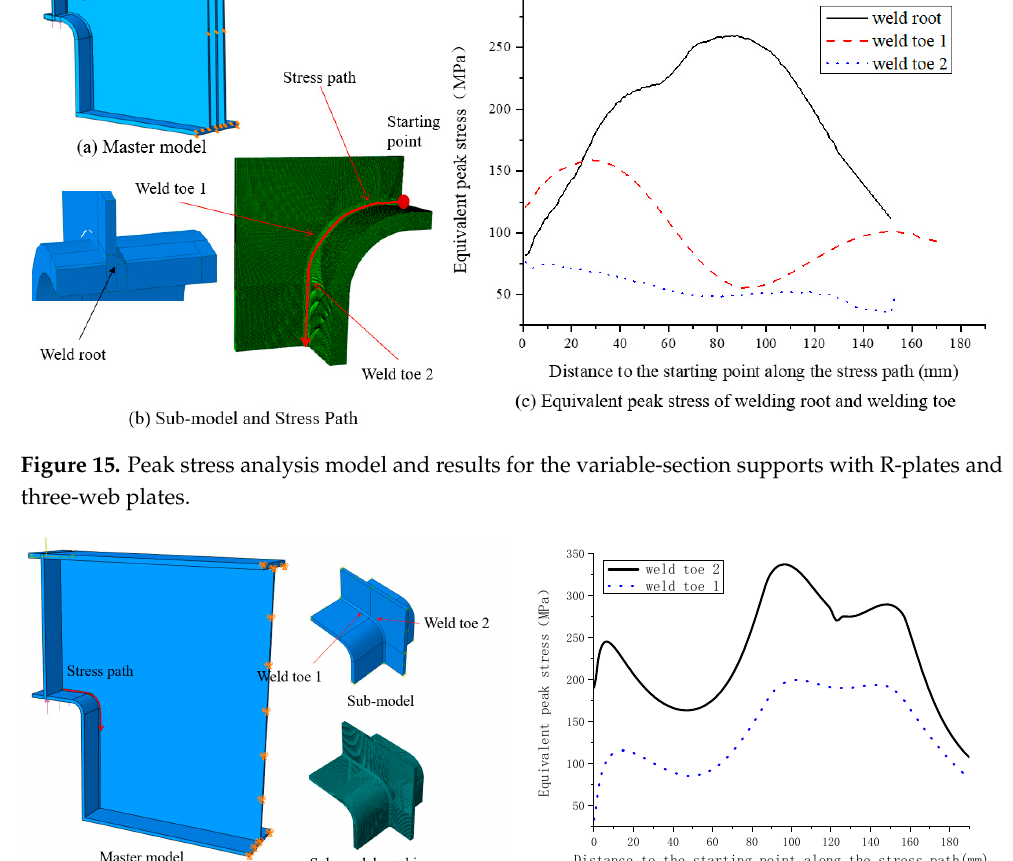
Figure 17. Peak stress analysis model and results for the variable-section supports with right-angle curved end plates. For the variable-section supports with right-angle end plates, the applied vertical support reaction at the support was 157.5 kN. Using the same method as that described above, the equivalent peak stresses in the two weld toes of the weld between the end plate and the plug-in plate were calculated. The finite element analysis model, the stress path, and the calculation results are shown in Figure 18. The calculation results showed that there were large stress concentrations in the weld between the end plate and the plug-in plate. A comparison of the equivalent peak stresses in Weld Toe 1 and Weld Toe 2 showed that the stress concentrations in Weld Toe 2 were obviously greater than those in Weld